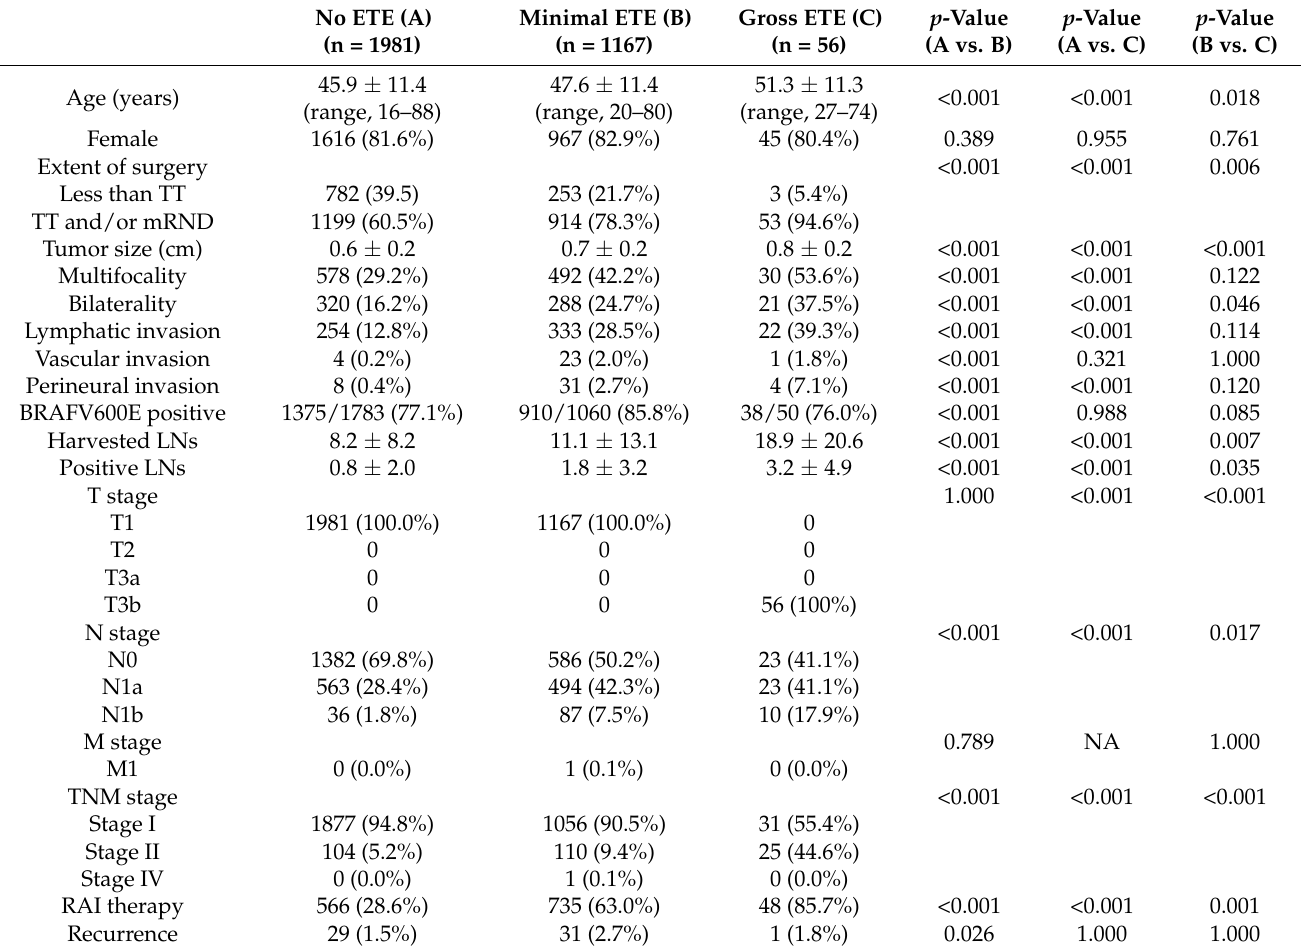
Table 5. Sub-analysis of clinicopathological characteristics according to ETE status in